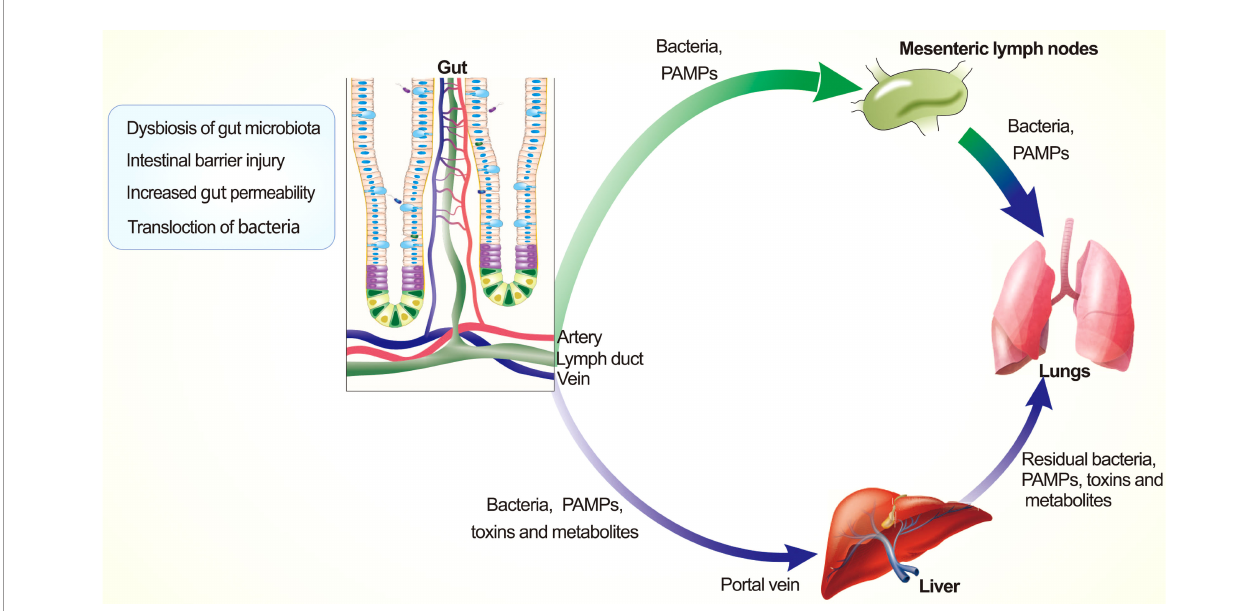
FIGURE 3 | Pathways of intestinal bacterial translocation. Intestinal pathogenic bacteria, PAMPs, and metabolites translocate to the lung via lymphatic route and blood circulatory